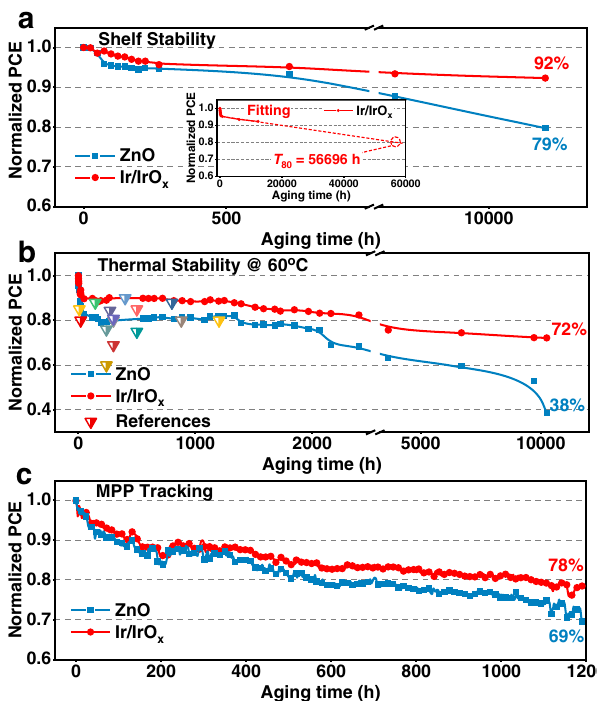
Fig. 4 | Device stability. PCE evolution plots of champion devices in the stability test of shelf storing ( a ), thermal aging ( b ), and maximum power point (MPP) tracking under 100mW/cm 2 illumination ( c ). The insert graph in Fig. 3a is the corresponding fi ttinglineofPCEevolutionplotofchampionIr/IrO x -baseddevicein shelf stability. Triangles in Fig. 3b are the thermal-stability data summarized from